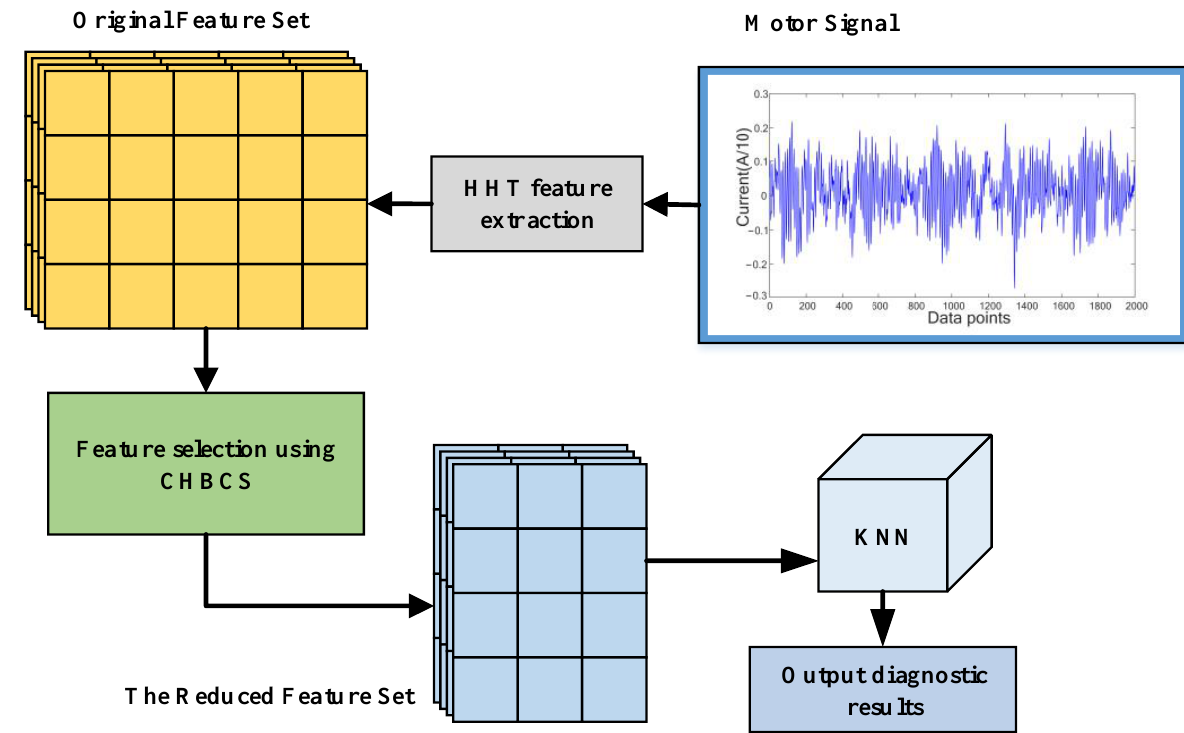
Figure 10. Diagram of the fault diagnosis model.